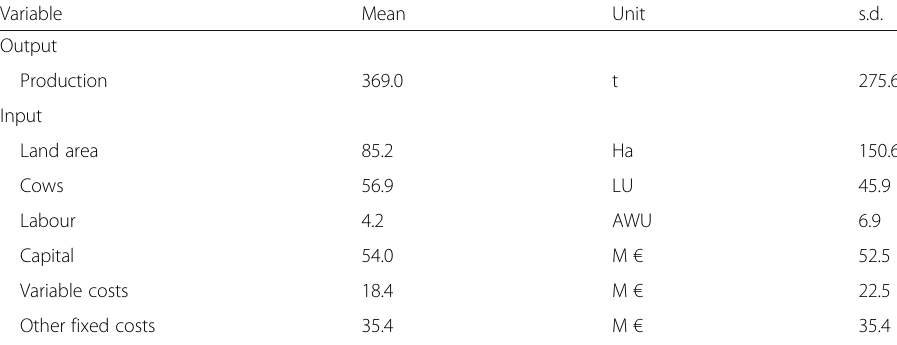
Table 3 Description of explanatory variables — average annual value